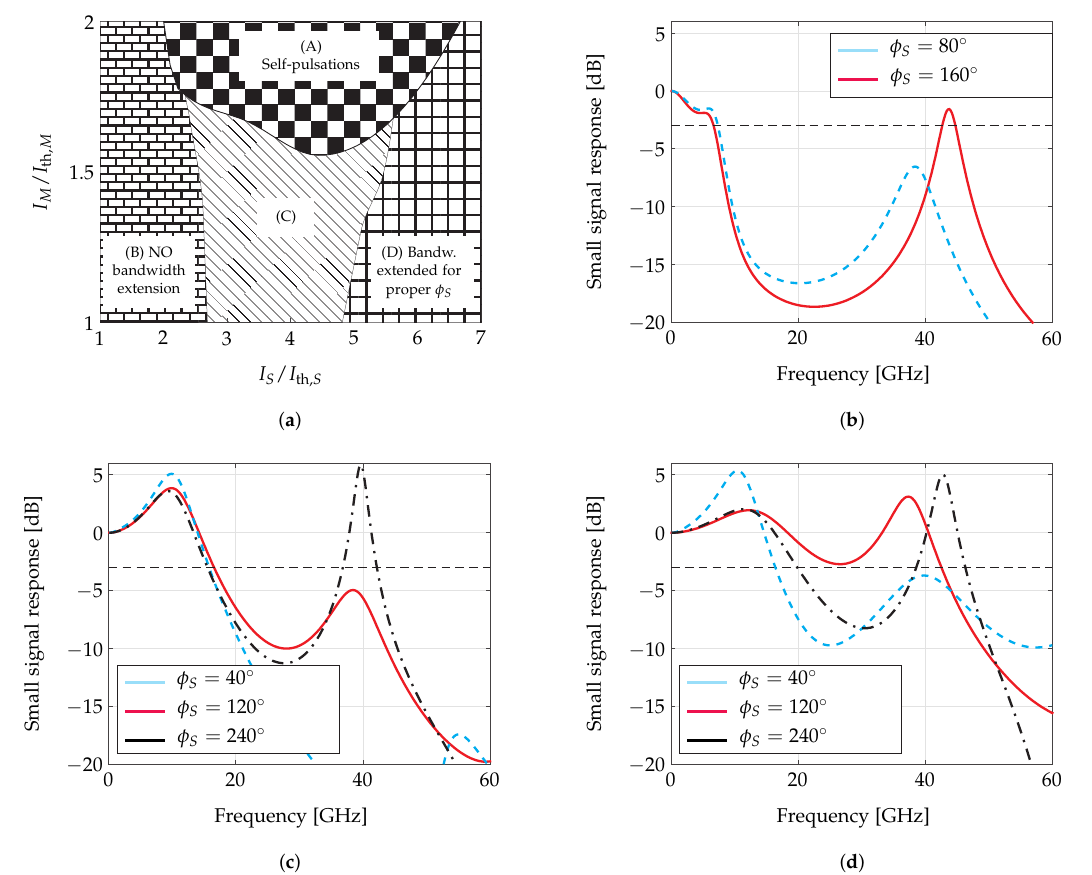
Figure 6. ( a ) Map in the normalized master and slave active sections’ current plane indicating the four typical dynamic behaviors found tuning the phase control φ S . Examples of the typical small signal modulation response obtained with different values of φ S in the B, C, D regions are reported in ( b , c , d ) of this figure for the structure characterized by the red square marker in Figure4b. The horizontal dashed lines represent the 3dB level for the modulation −